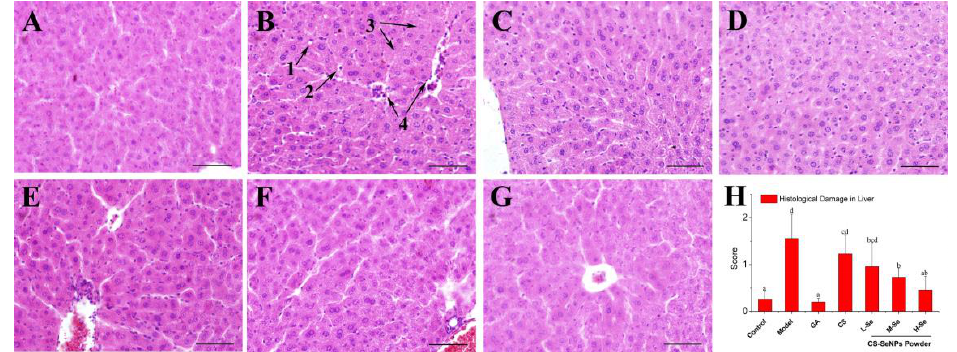
Figure 5. Histology of liver sections upon hematoxylin and eosin (H&E) staining 200×. ( A ) Normal control, ( B ) Model, ( C ) GA, ( D ) CS, ( E ) L-Se, ( F ) M-Se, ( G ) H-Se, and ( H ) histological damage score of each group. Scale bars represents 25 μm. Arrows: 1, ballooning degeneration; 2, hydropic degeneration; 3, lytic necrosis; 4, inflammatory cell infiltration. a–d Means within a panel with di ff erent letters di ff er